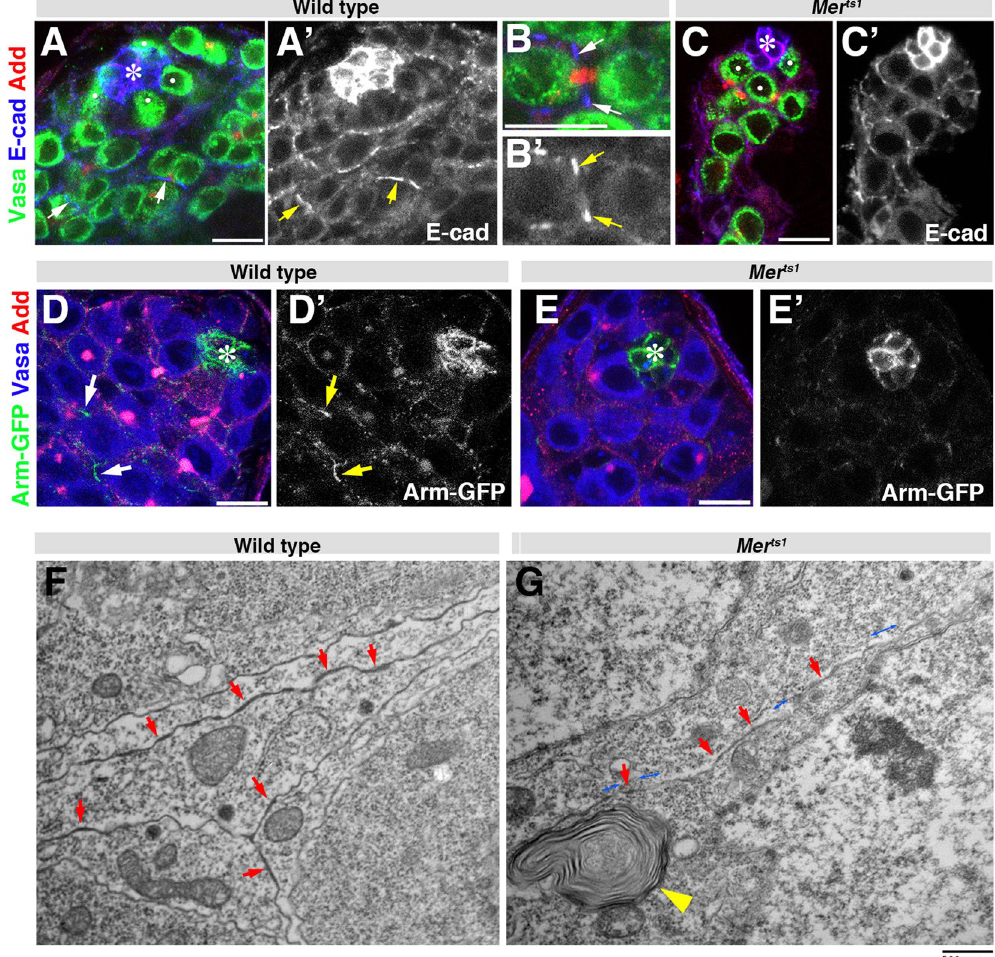
Figure 3. Mer is required for stability of adherens junction between CCs. ( A – C ) Apical tip of a wild-type ( A and B ) and Mer ts1 mutant ( C ) testis stained for E-cadherin (Blue), Vasa (Green), and Add (Red). GSCs are indicated by white dots. Hub ( * ). Bar, 10 µ m. ( D and E ) Apical tip of wild-type ( D ) and Mer ts1 mutant ( E ) testis visualized for Arm-GFP (Green), Vasa (Blue), and Add (Red). ( F and G ) Transmission electron microscopy showing junctions between two somatic cells in a wild-type ( F ) and Mer ts1 ( G ) testis. Arrows indicate cell-cell junctions. Blue, double-headed arrows in ( F ) indicate gaps in cell-cell junction structure. We noted that Mer ts1 mutant somatic cells have numerous multilamellar bodies (yellow arrowhead), although its meaning is currently unclear. Bar, 500